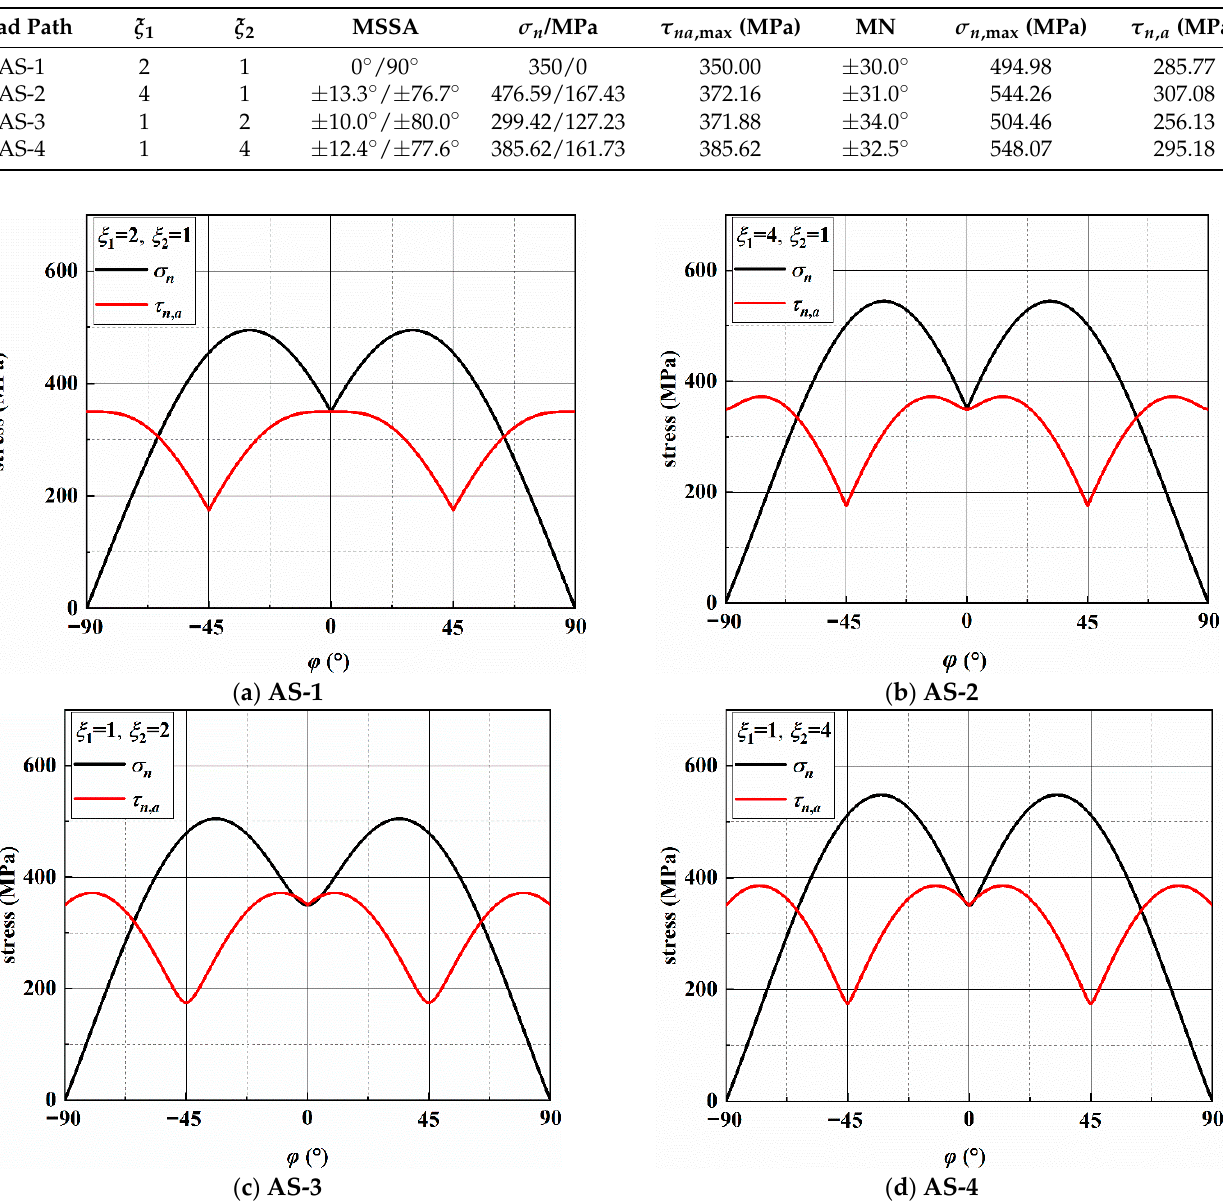
Figure 5. Variation in the stress components on different planes.